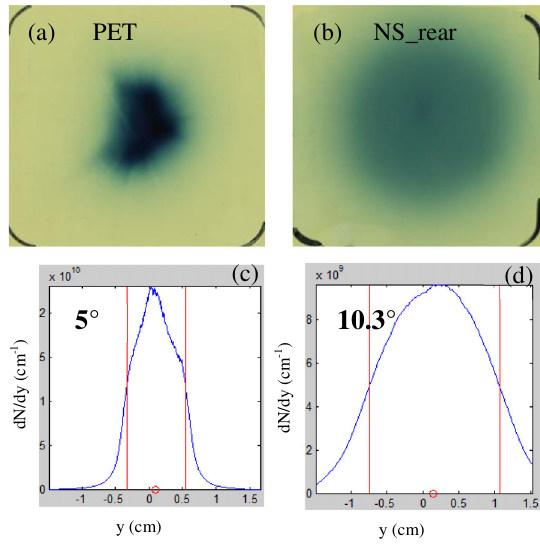
FIG. 4. Examples of radiochromic films (obtained accumulat- ing 2 shots) showing spatial profiles of proton beams generated from PET target (a) and from NS (b). (c) and (d) represent the rear lateral profile of the proton beam respectively for PET and NS rear targets.